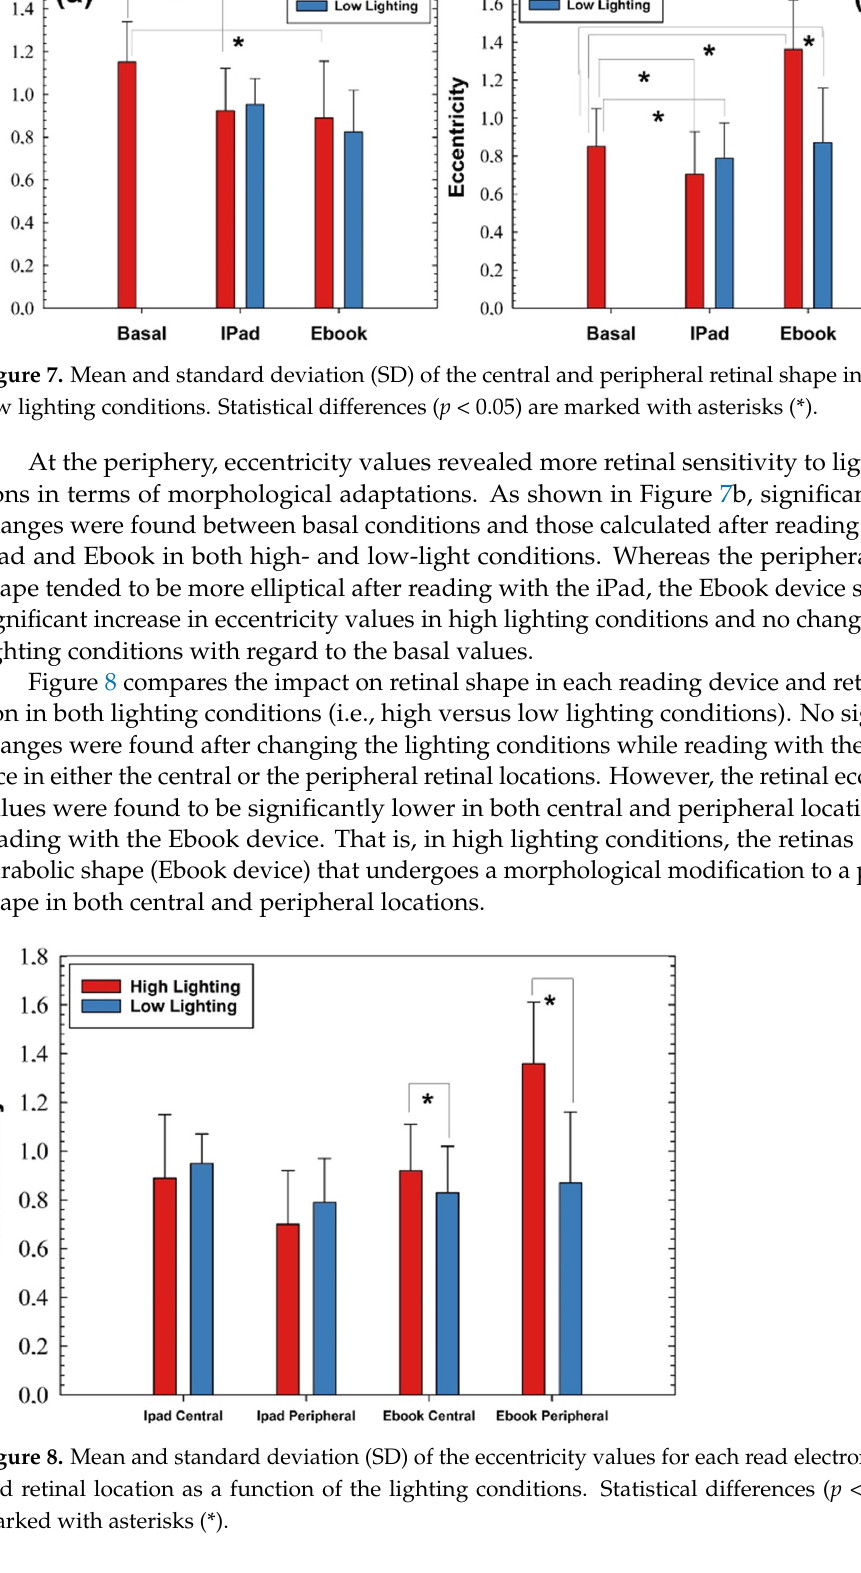
Figure 8. Mean and standard deviation (SD) of the eccentricity values for each read electronic device and retinal location as a function of the lighting conditions. Statistical differences ( p < 0.05) are marked with asterisks (*).